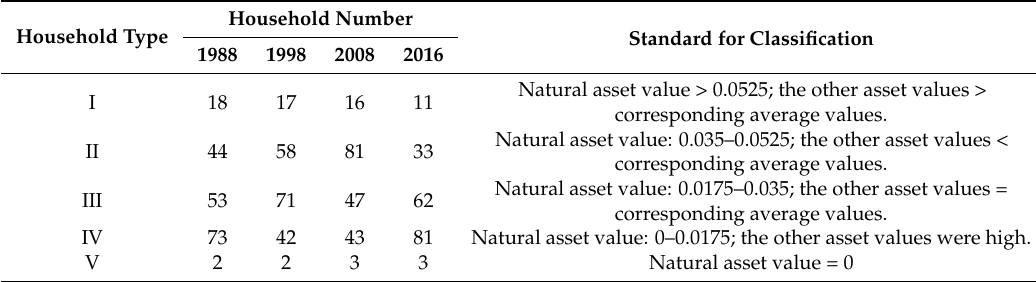
Table 7. Household classification from 1988 to